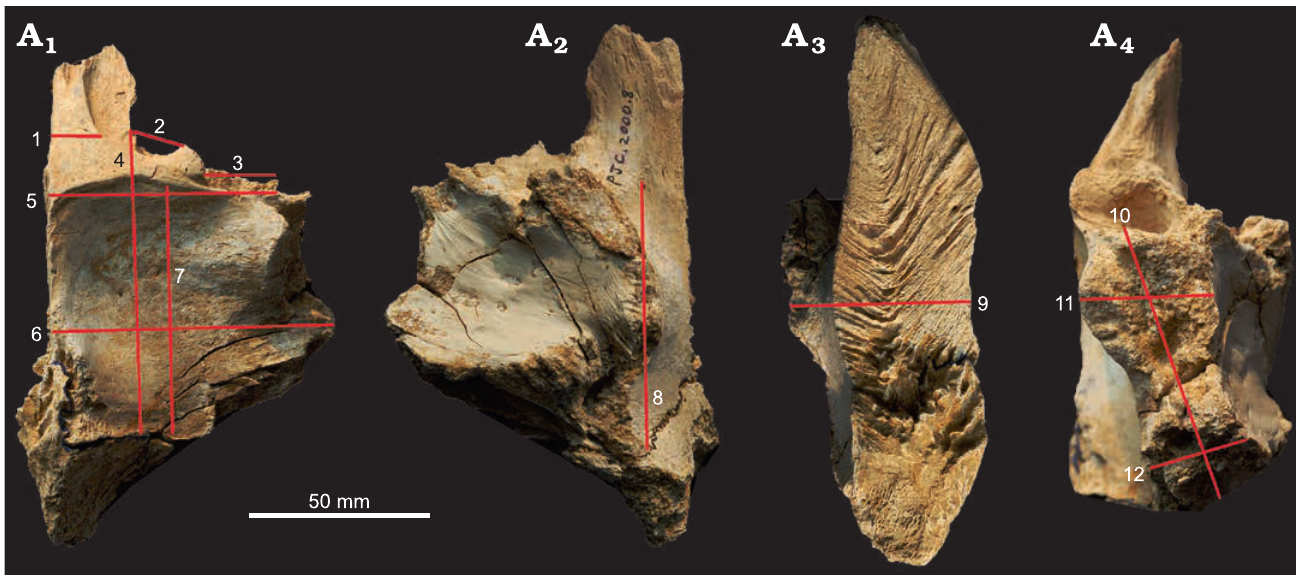
Fig. 2. Measurement parameters used in study, with frontal of Tarbosaurus bataar Maleev, 1955a (MPC-D 107/22), from Bugiin Tsav, Nemegt Formation, Maastrichtian, as an example. Measurement parameters in dorsal (A 1 ), ventral (A 2 ), medial (A 3 ), and lateral (A 4 ) views. 1, width of the nasal process; 2, width of the prefrontal suture; 3, width of the lacrimal socket; 4, length of the frontal between prefrontonasal process and the frontoparietal suture; 5, width of the frontal between medial edge of the orbital slot and the midline; 6, width of the frontal between the most lateral point of the posterior shelf and the midline; 7, length of the dorsotemporal fossa between the middle of the dorsotemporal ridge and the frontoparietal suture; 8, length of the brain between most anterior point of the olfactory bulb fossa and the most posterior point of the cerebral fossa; 9, depth of the frontal at the region that is immediately anterior to the most anterior point of the sagittal crest; 10, length of the postorbital suture between the most anterior point of the anterior part and the most posterior point of the posterior part of the suture; 11, dorsoventral depth of the anterior part of the postorbital suture; 12, dorsoventral depth of the posterior part of the postorbital suture. The same numbers appear in Figs. 3–5 and Table 1.